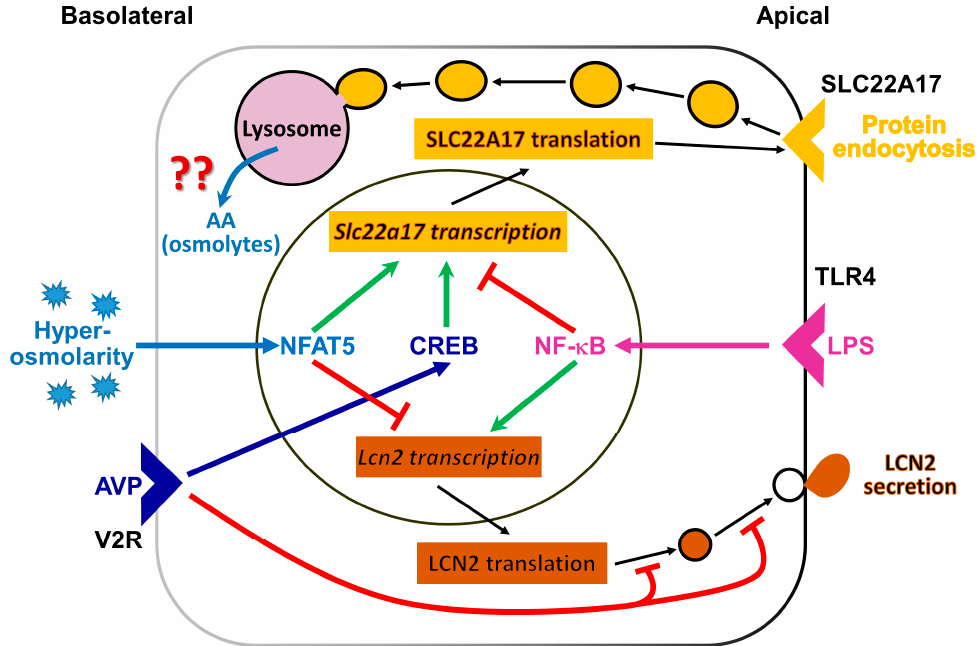
Figure 7. Regulation of lipocalin-2 receptor (SLC22A17) and lipocalin 2 (LCN2) abundance in